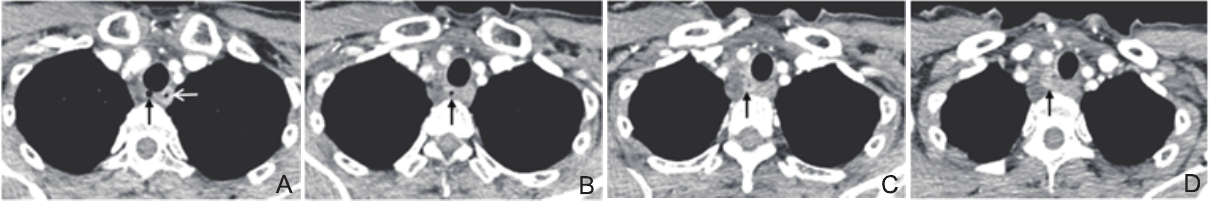
Figure 9 CT images of the nodulea. (A) Tiny diverticulum (closed arrow indicating) communicating with the trachea passage at the posterior wall. The open arrow indicates the esophagus passage. (B) Tiny gas-filling structure (arrow indicates) seen posterior to the trachea at an upper level is postulated